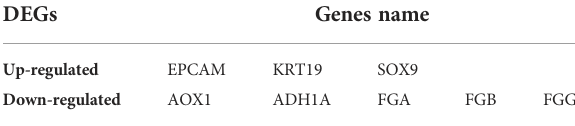
TABLE 2 The 8 DEGs obtained by STRING included 3 up-regulated and 5 down-regulated genes.